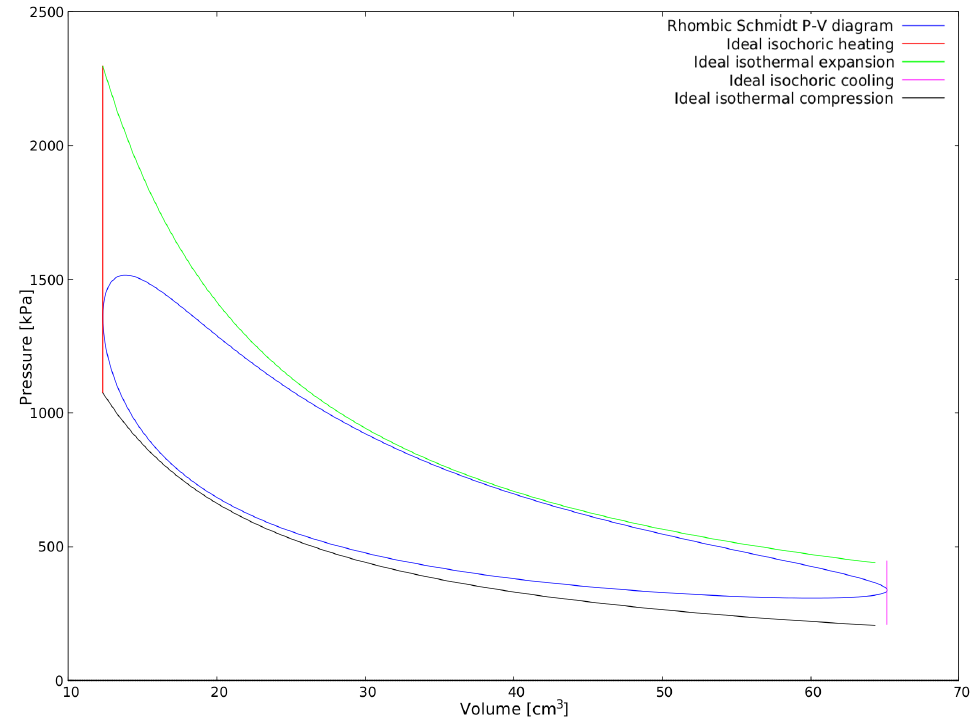
Figure 13. Beta with rhombic drive P-V diagrams.